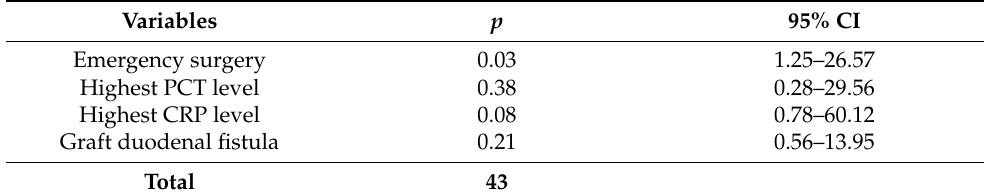
Table 5. Multivariate analysis of potential predictors related to 30-day